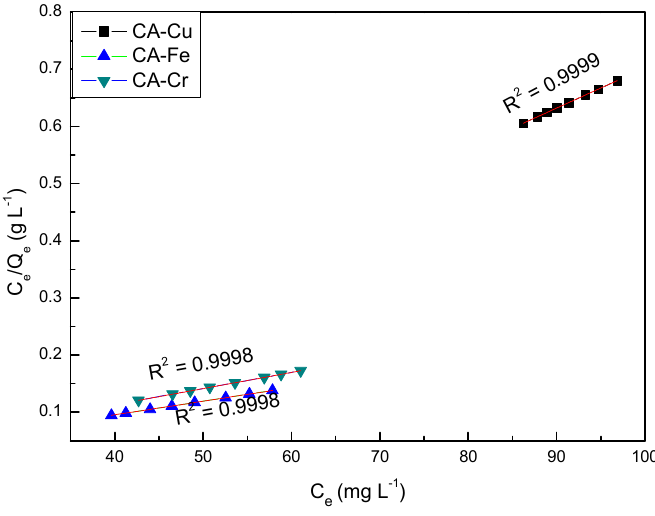
Figure 2. Langmuir isothermal adsorption model for CA-X.